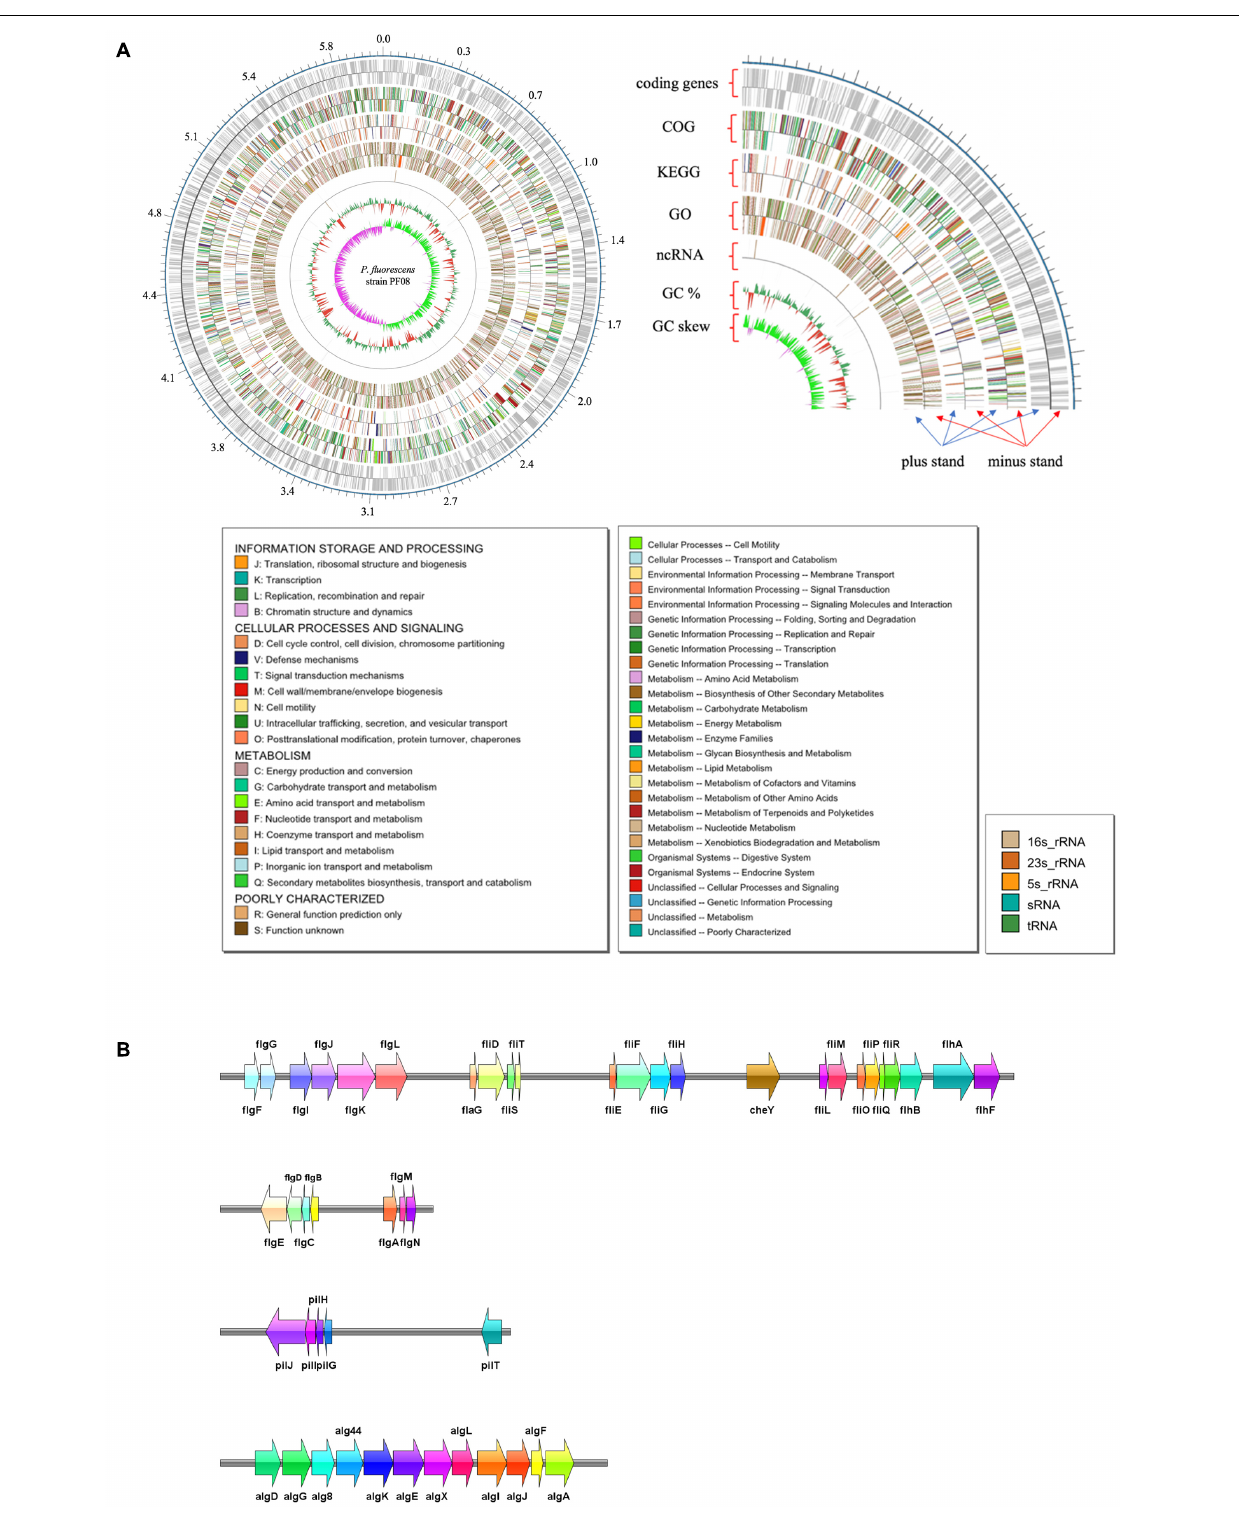
FIGURE 1 | Graphical map of the completed chromosome of Pseudomonas fluorescens strain PF08. Numbers represent megabases (Mb). The type shown on the legend is the type that appears in the annotation result. The color of the box on the left corresponds to the color on the map (A) . The spoilage-related gene clusters in the genome of P. fluorescens strain PF08 (B)